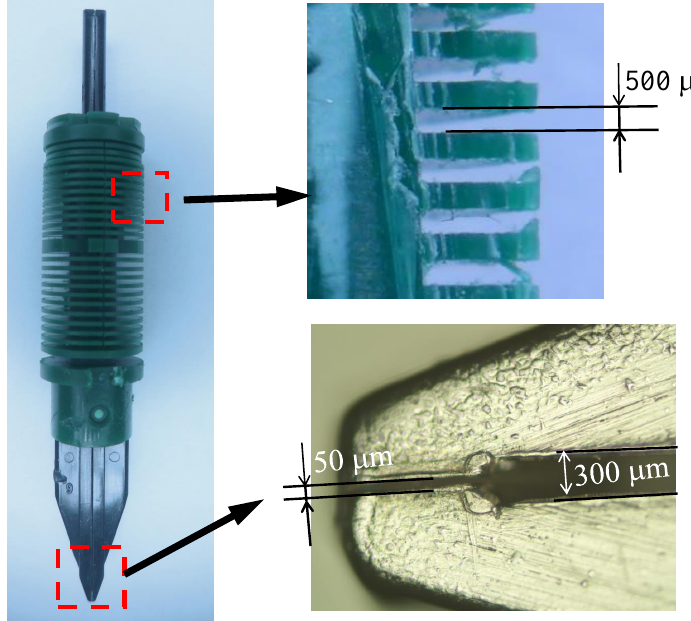
Figure 4. The dimensions of the print